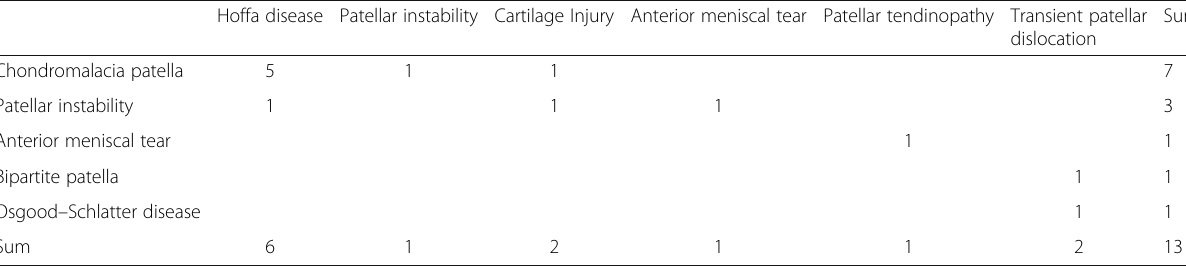
Table 7 Demonstrating the overlapping between patients who had more than one disease entity